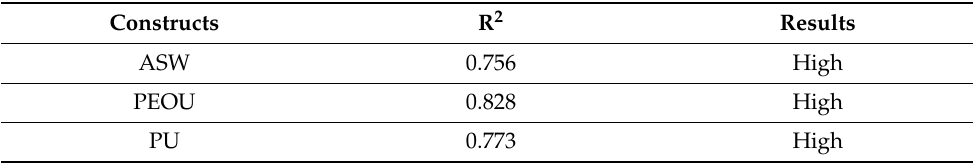
Table 9. R 2 of the endogenous latent